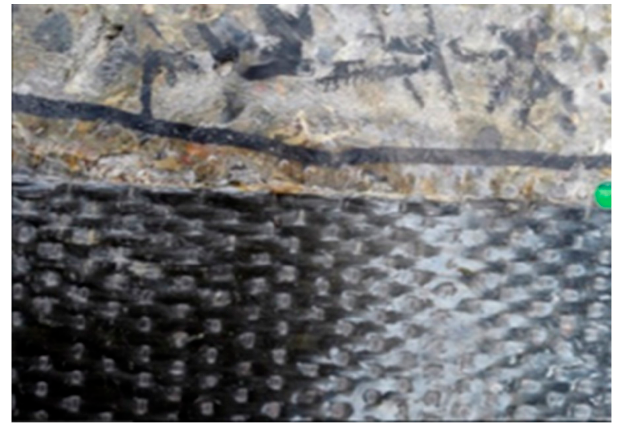
Figure 10. Surface rust on the affixed steel plate after freeze–thaw erosion.